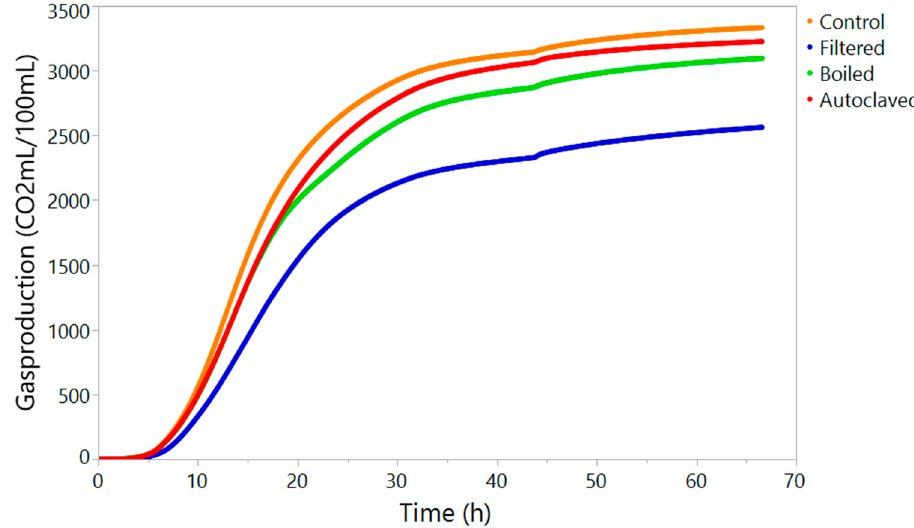
Figure 2. Ankom gas production curve over 68 h for four pretreated worts inoculated with the same yeast.